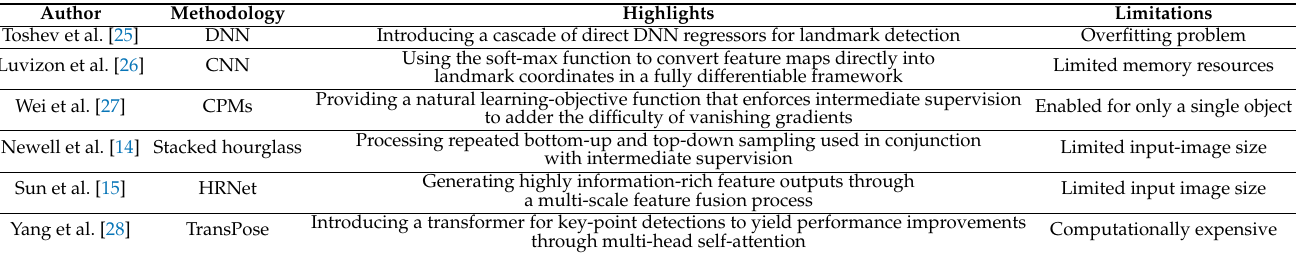
Table 2. A summary table of the landmark detection.